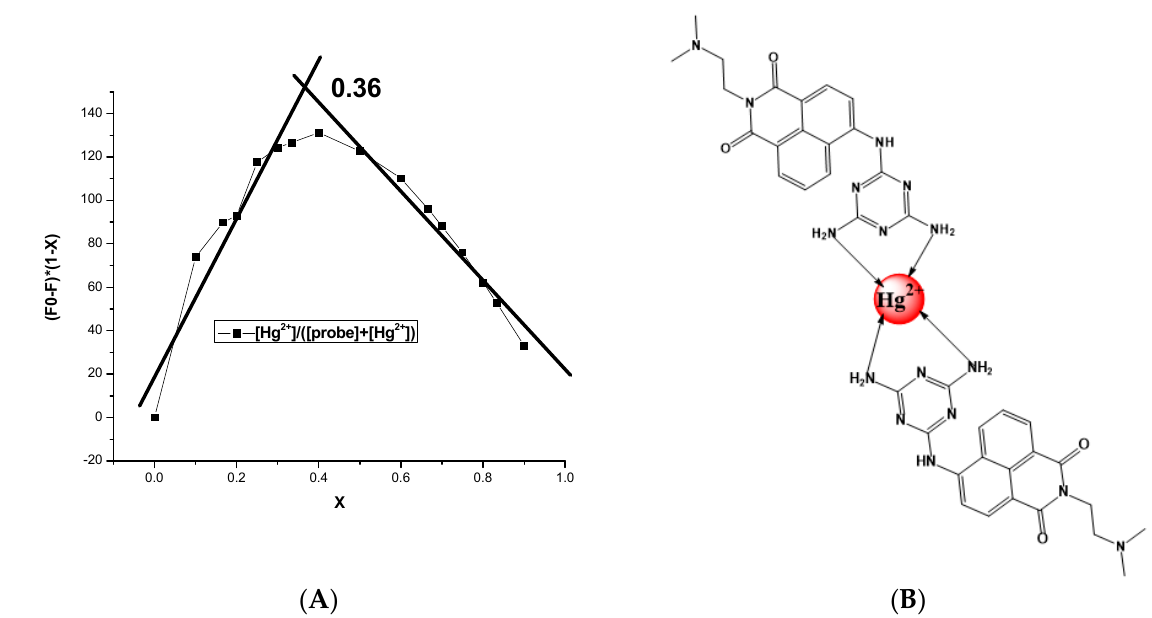
Figure 6. ( A ) Job’s plot and ( B ) suggested structure of probe/Hg 2+ complex. Furthermore, the selectivity of the new chemosensor to Hg 2+ response has been examined by measuring the emission spectrum of the probe in the presence of 5 equivalents of both Hg 2+ and the interfering cation or anion. As shown in Figure 7, the emission response of the probe toward the presence of Hg 2+ was not affected by the coexistence of any of the interfering cations or anions under the study.